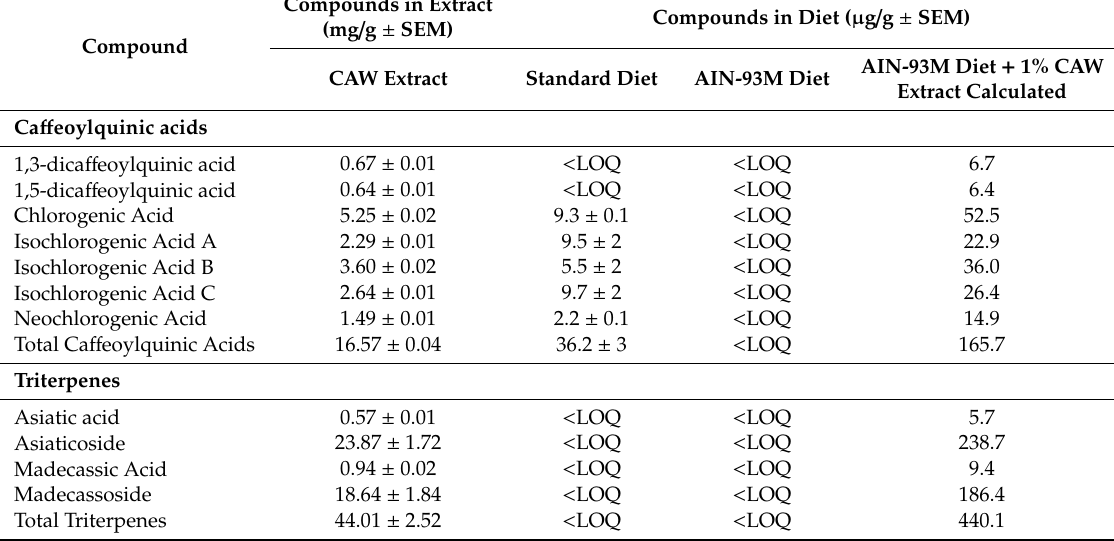
Table 1. LC-HRMS / MS quantification of phytochemicals in vehicle mouse diets and Centella asiatica water extract